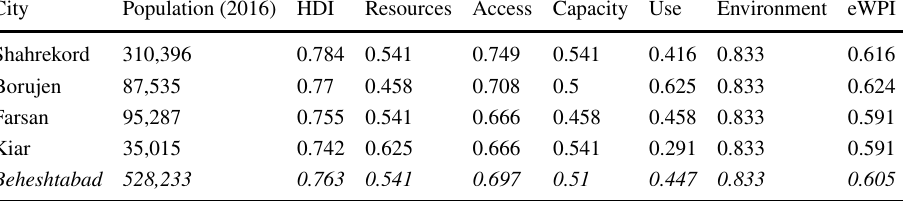
Table 5 eWPI main criteria for districts of Beheshtabad and the whole Basin (community and watershed